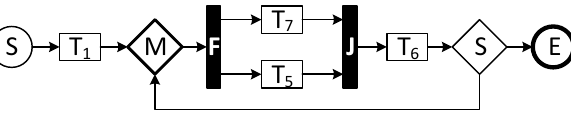
Figure 9. A simple (sound) workflow